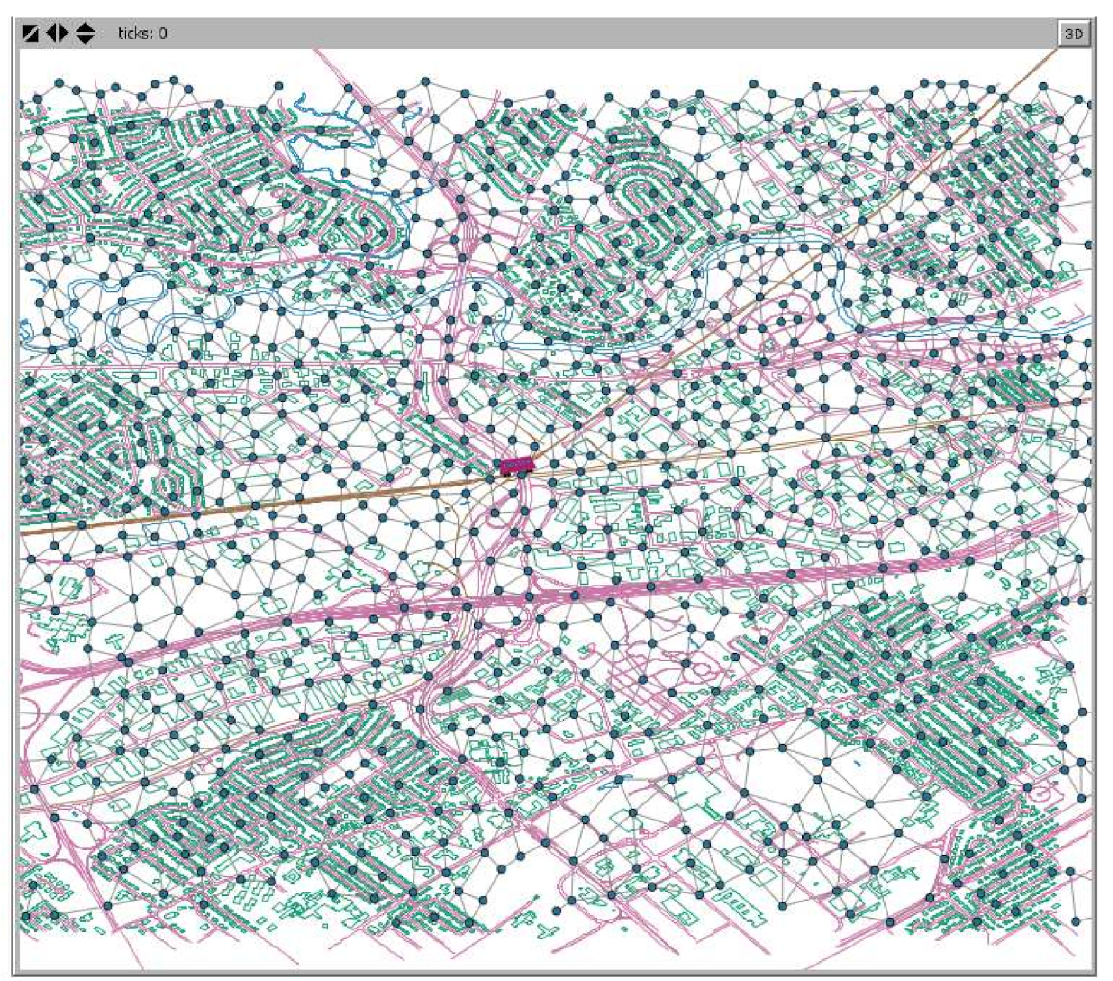
Figure 10. A Netlogo window showing a part of Quebec City with buildings in green, roads in purple, railway in brown, rivers in blue, sonometers network (dots and links) and a red locomotive creating